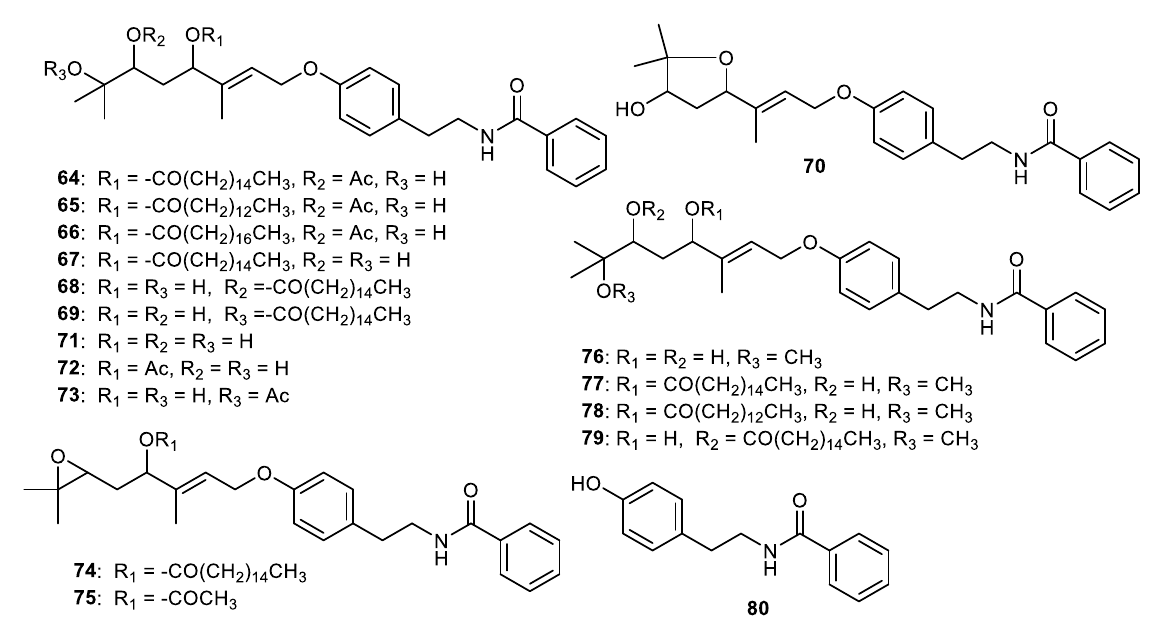
Figure 10. Structures of alkaloids 64 – 80 .